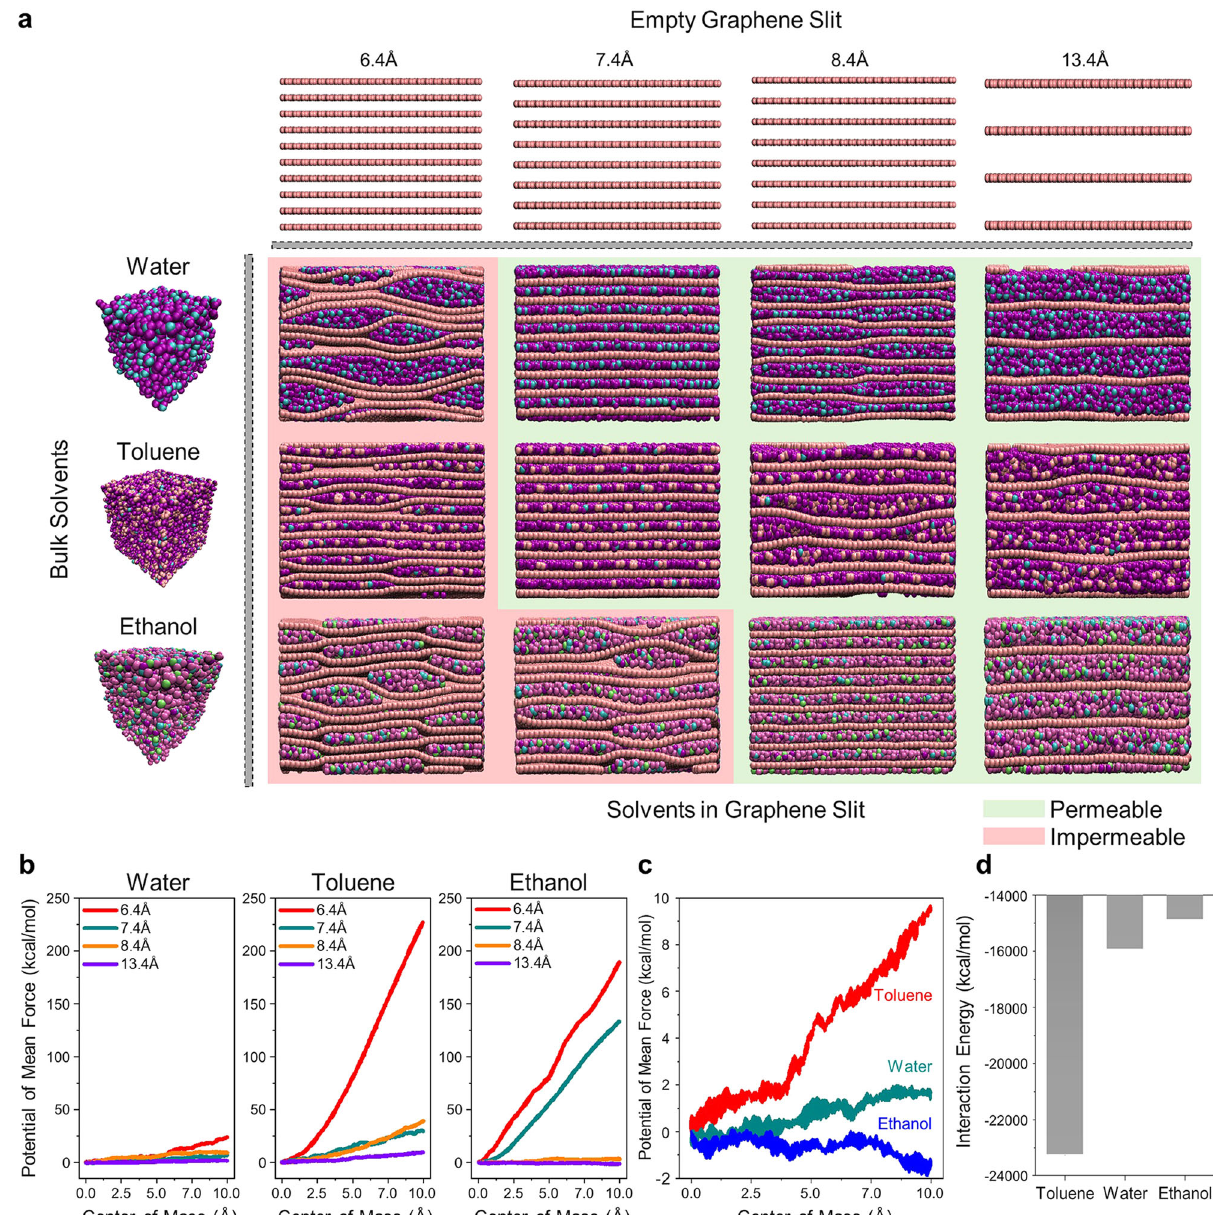
a . c Potentialsofmeanforce ofwater,toluene,andethanolatad-spacingof13.4Å. d Interaction energy between graphene layers and solvents within the d-spacing of